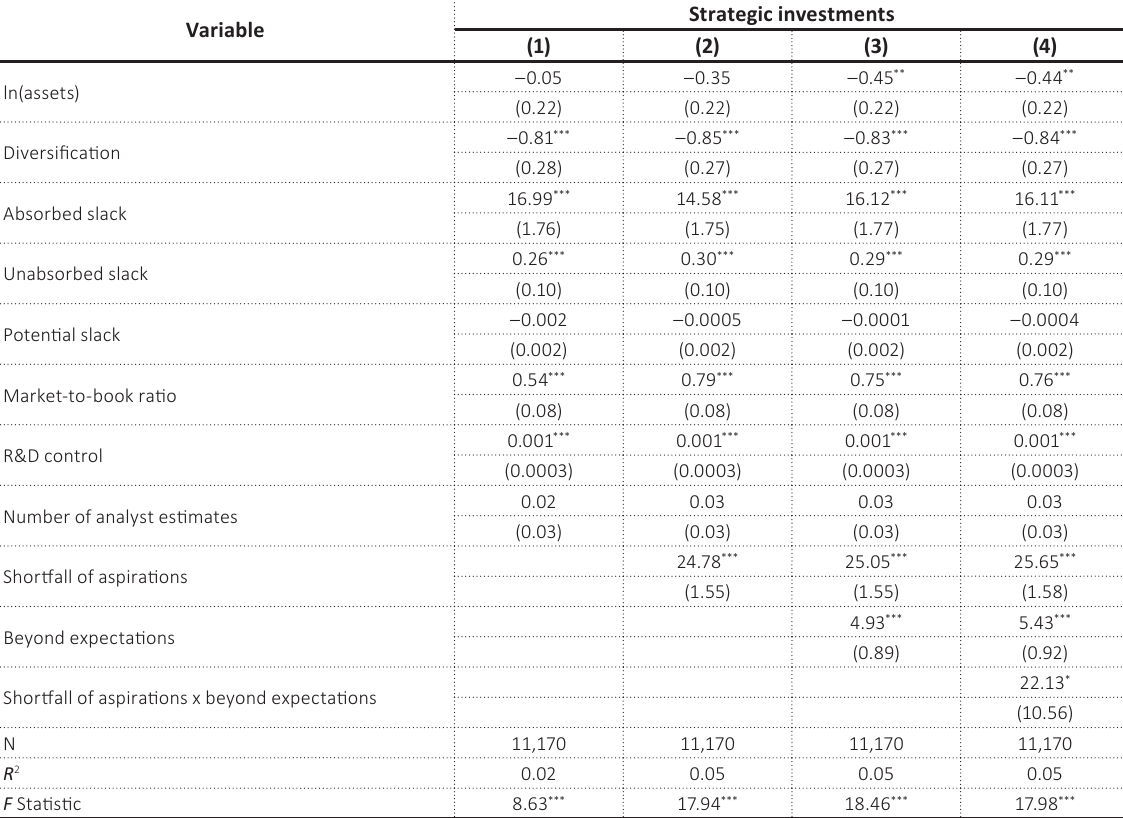
Table 2. Regression results from fixed-effects